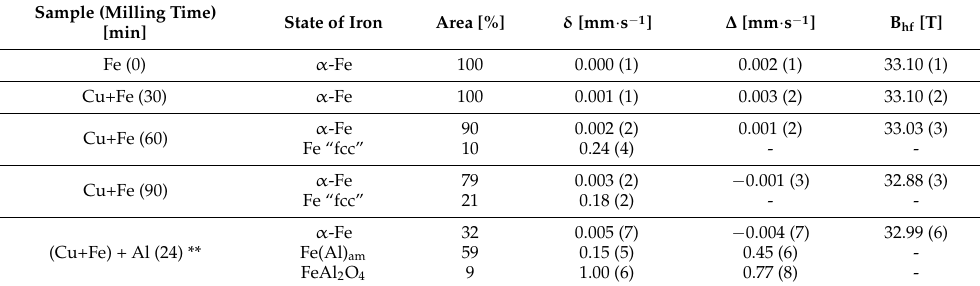
Table 2. Hyperfine parameters of the Mössbauer spectra were recorded from the powders *. Sample (Milling Time)